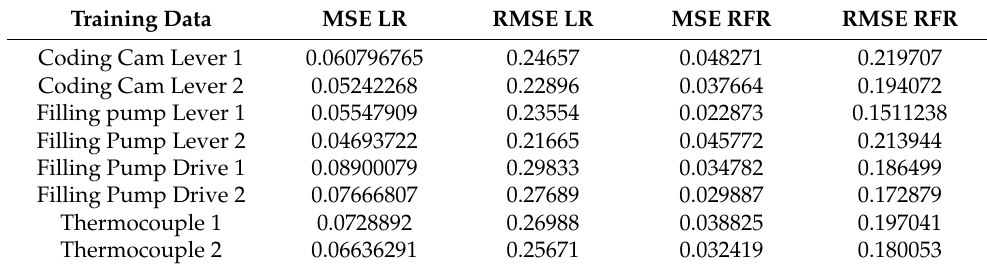
Table 6. MSE and RMSE result from training